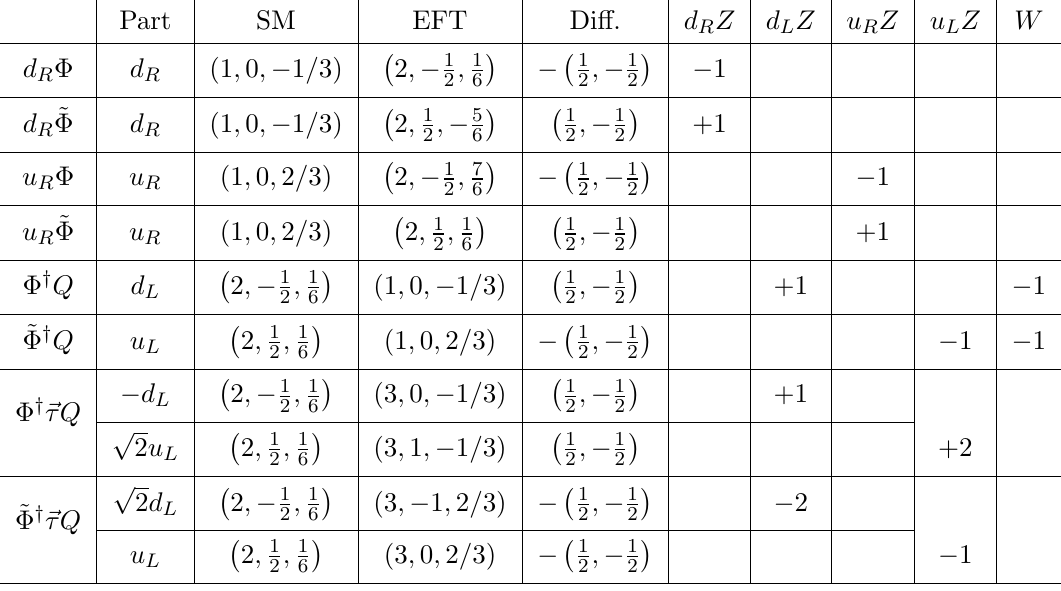
Table 7 . Derivation of FCNC interactions generated by Derivative operators . Z couplings are in